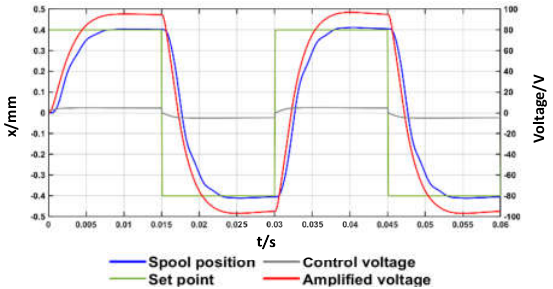
Figure 11. Simulated closed-loop step tests ± 0.4 mm ( p p − p T = 70 bar, C p = 90 Ns/m, m p = 80 g; ω n , a = 1400 rad/s).